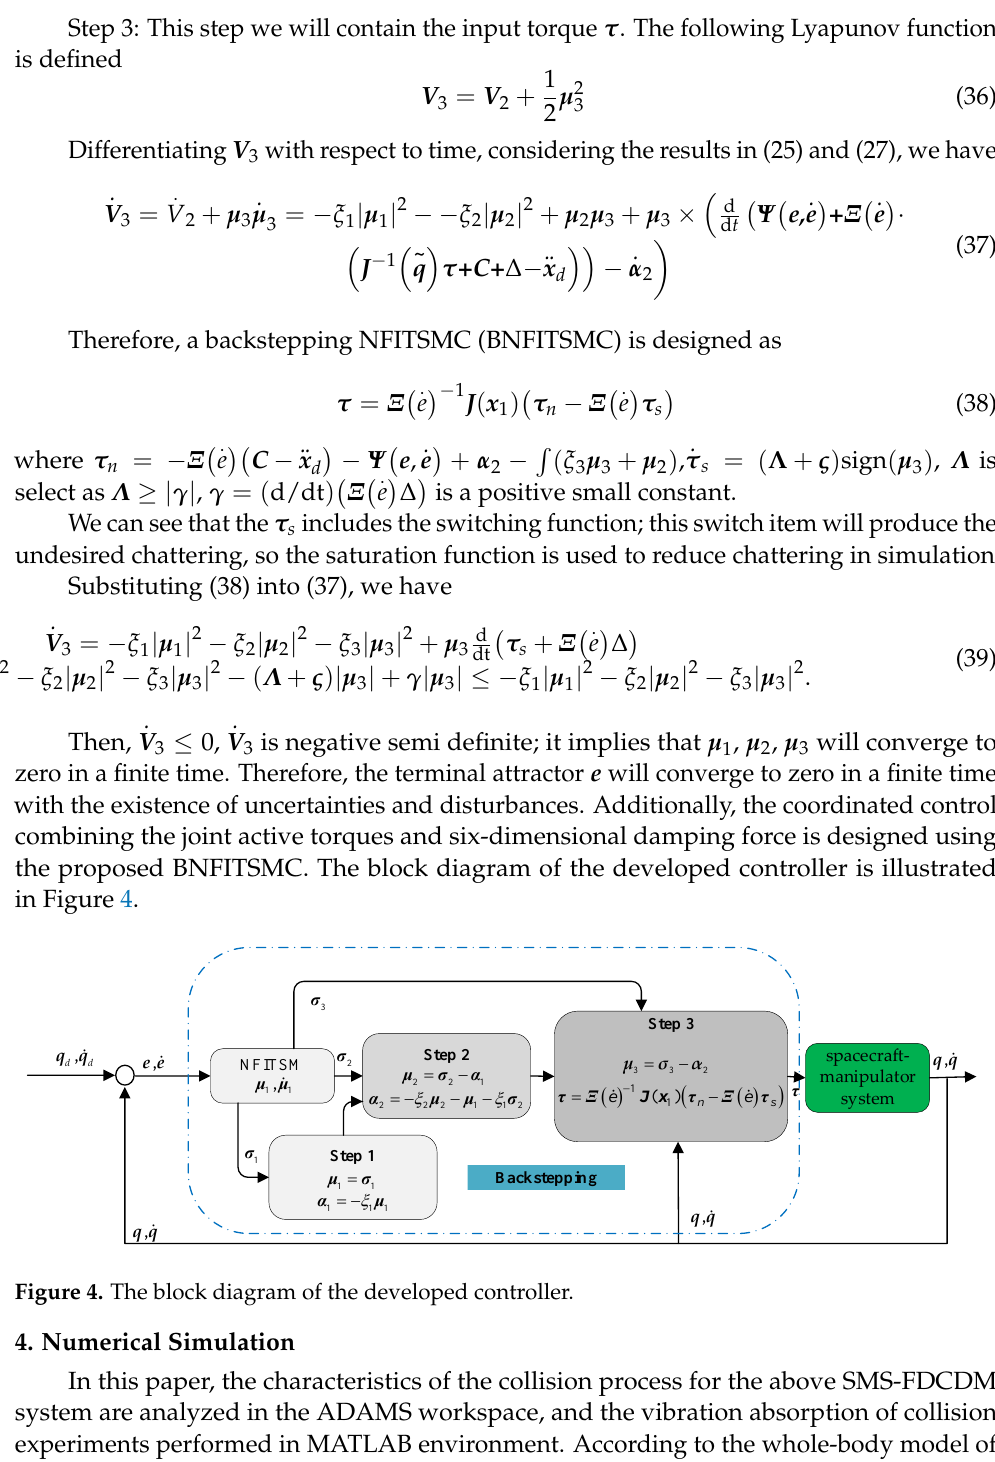
Table 1. Dynamic parameters of the SMS-FDCDM model. Rigid Bodies k